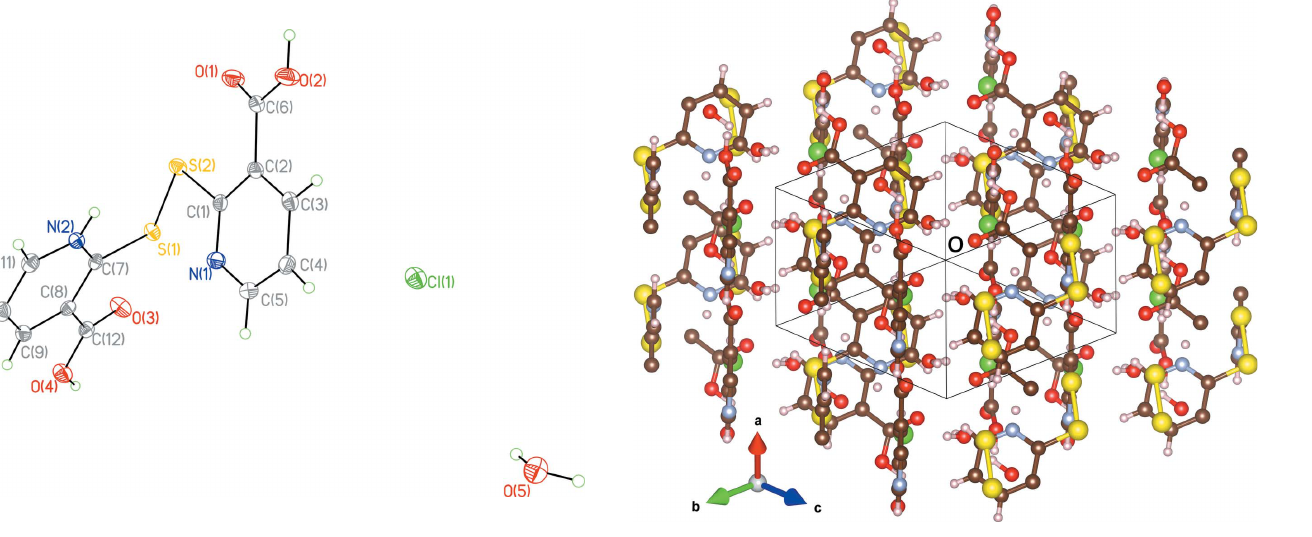
Figure 1 Displacement ellipsoid plot (50% probability level) of H(2- mnaH) 2 Cl (cid:2) H 2 O.